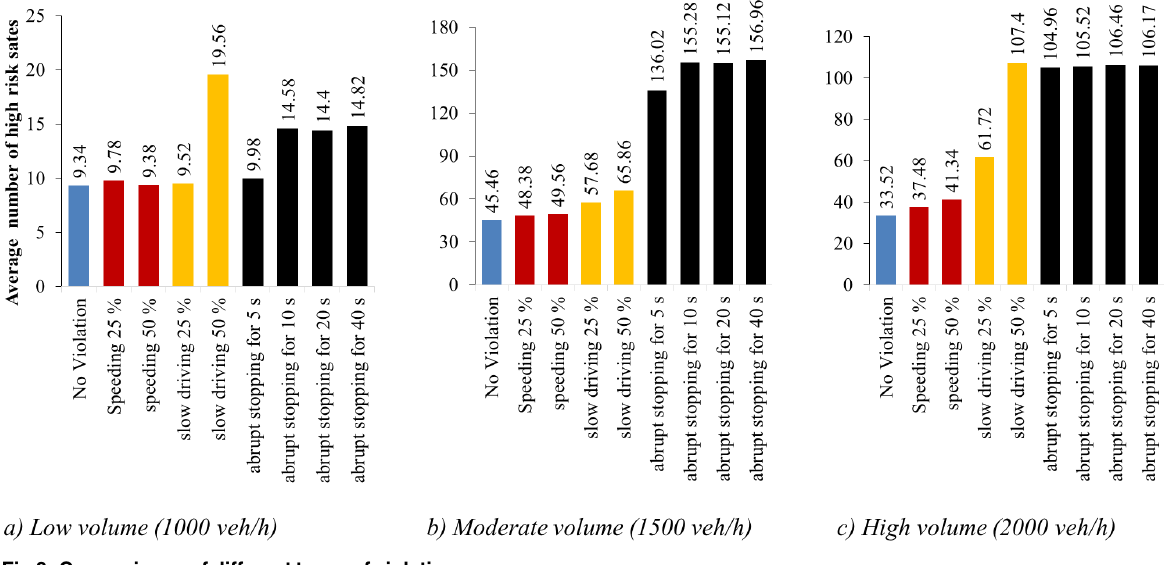
Fig 8. Comparisons of different types of